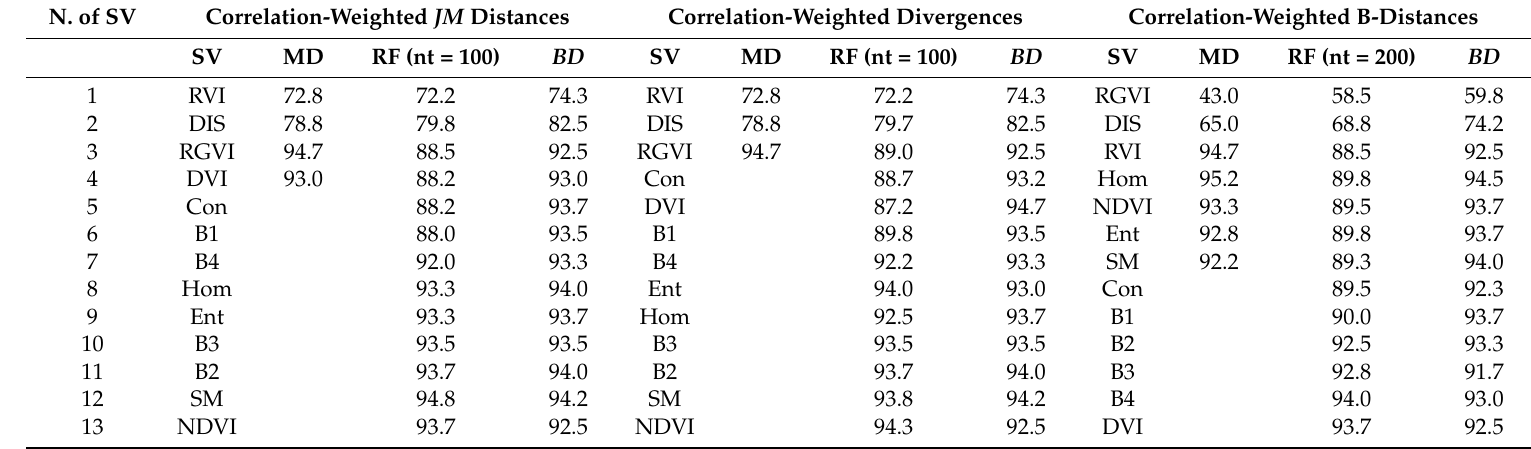
Table 2. Comparison of classification accuracy among three classifiers using the spectral variables selected based on correlation-weighted Jeffreys–Matusita ( JM ) distances, correlation-weighted divergences and correlation-weighted B-distances (SV: spectral variable; N. of SV: number of spectral variables used; BD : Bayesian discriminant classifier; MD: Mahalanobis distance classifier and RF: random forests; nt: number of trees used in